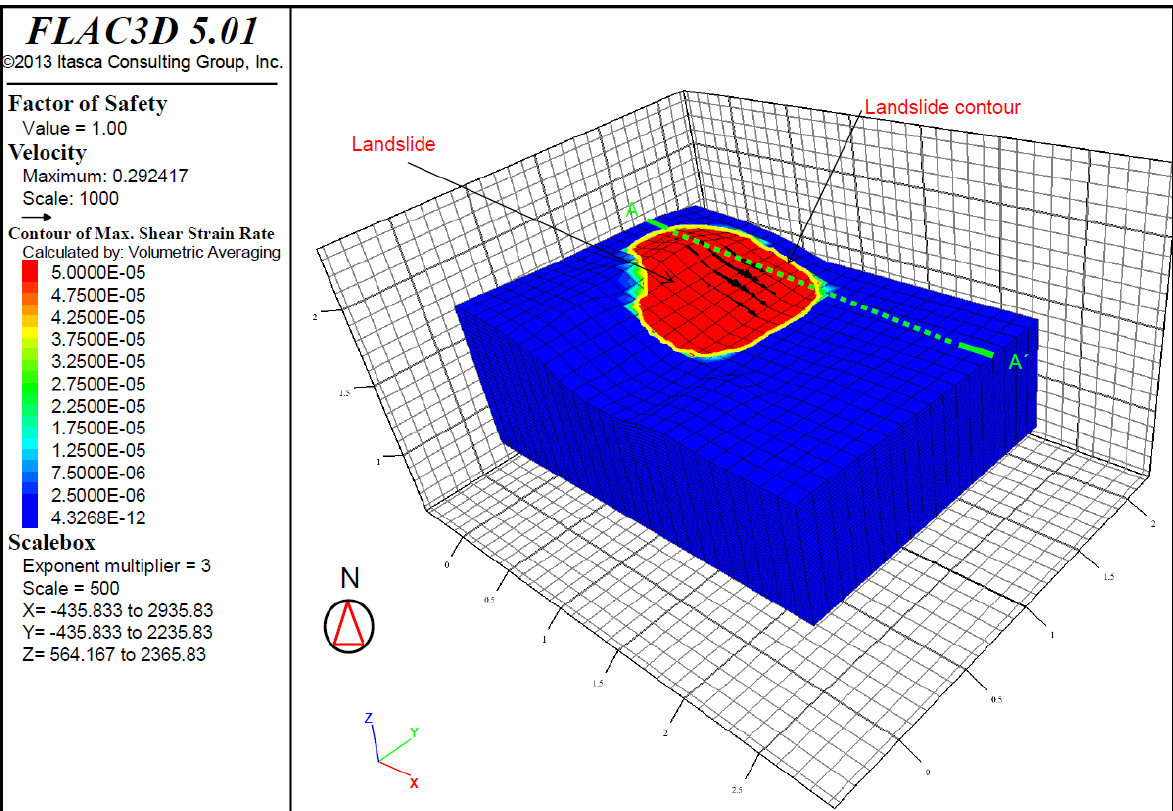
Figure 7. Sliding surface obtained by the numerical simulation 3D.